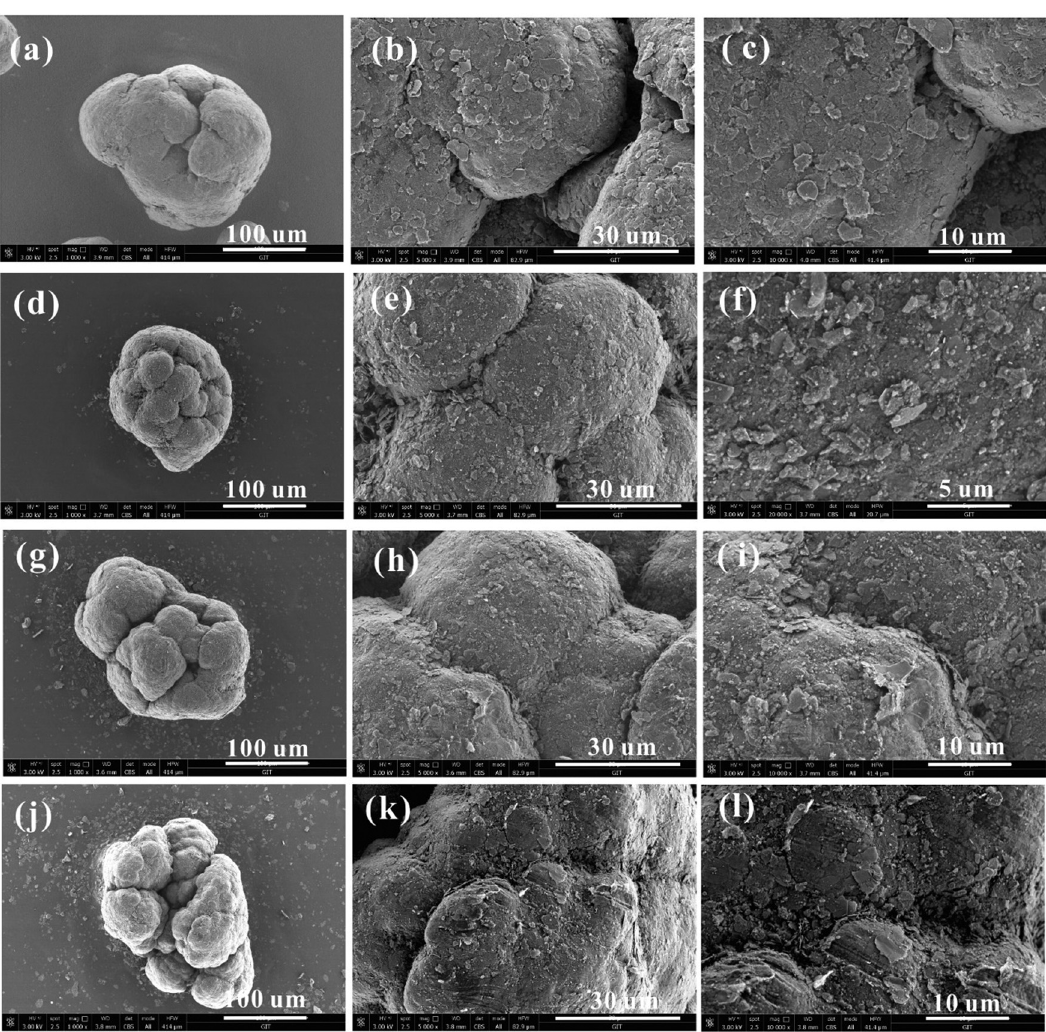
Figure A1: Particle morphological SEM images of BN - coated UHMWPE granules with ( a – c ) 2.1 vol%, ( d – f ) 9.4 vol%, ( g – i ) 21.6 vol%, and ( j – l ) 38.3 vol%